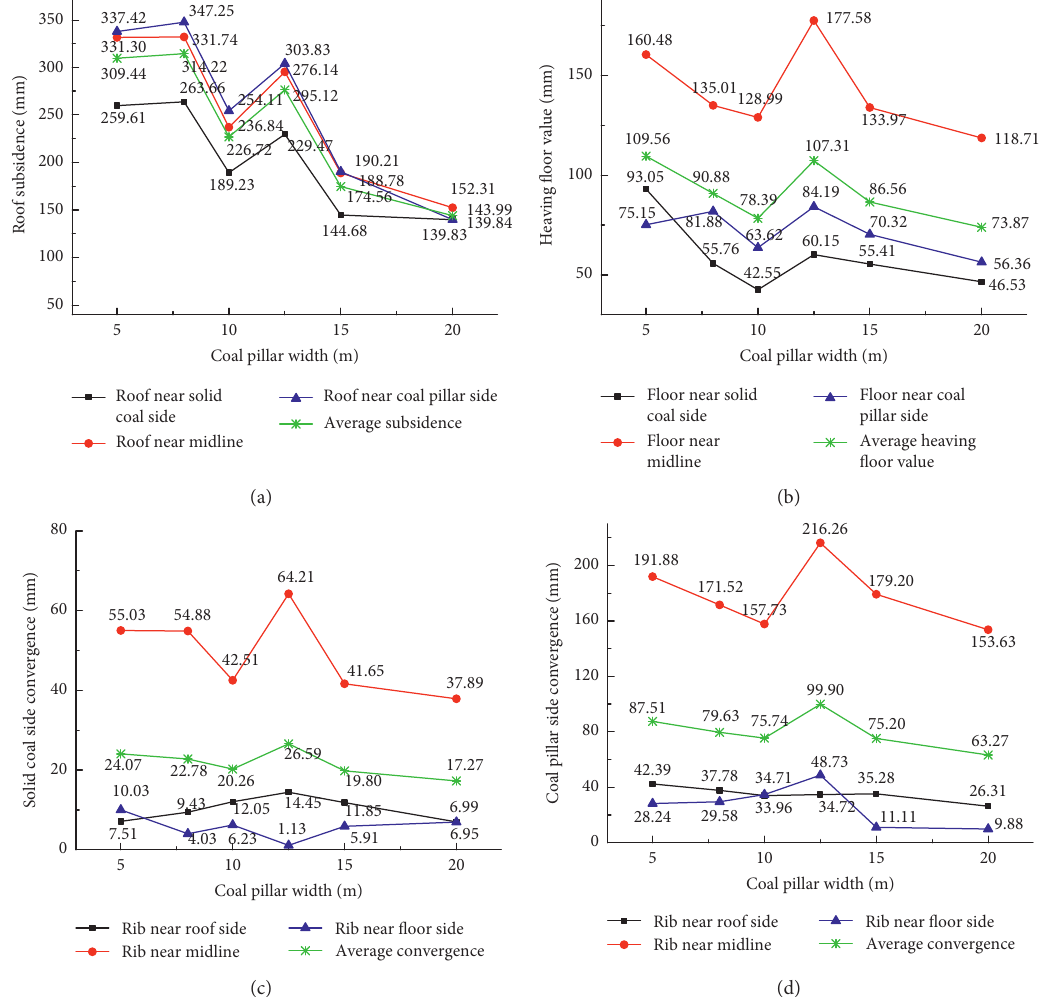
Figure 10: Variation of the displacement of the surrounding rock of the roadway under different width coal pillars. (a) Top plate sinkage. (b) Bottom drum volume. (c) Coal pillar gang approach amount. (d) Solid coal gang approach